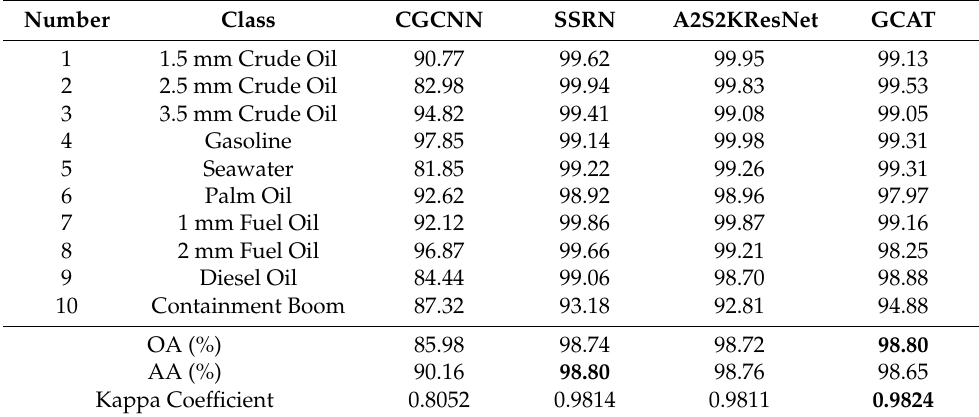
Table 4. Classification results of different methods for the oil type